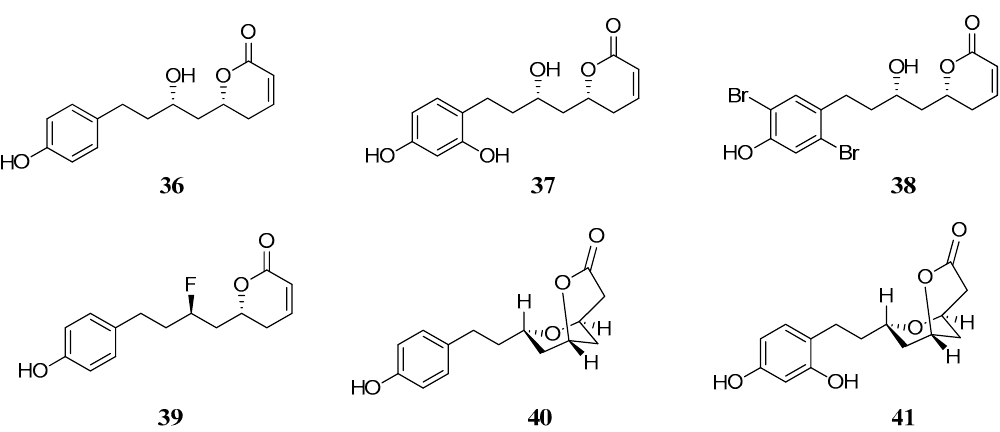
Figure 9. Structures and hCA inhibition data of dodoneine ( 36 ) and its analogues 37 – 41 by a stopped flow CO 2 hydrase assay [53].